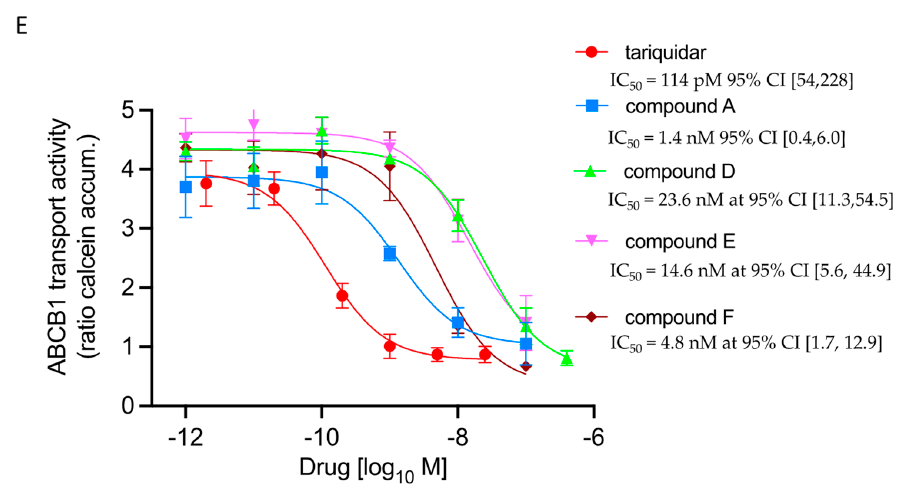
Figure 4. Potency of test compounds ‘A’, ‘D’, ‘E’, and ‘F’ for inhibition of ABCB1. ( A – D ) Histograms showing the increase in calcein accumulation in Flp-In-ABCB1 cells with increasing concentration of test compounds ‘A’, ‘D’, ‘E’, and ‘F’, respectively. ( E ) Non-linear regression analysis of ABCB1 activity (calculated using Equation (1)) versus test compound concentration. The regression curve for tariquidar is included for comparison. The mean activity +/ − standard error of the mean (SEM) is plotted ( n = 3 biological repeats). Calculated IC 50 and 95% confidence intervals are given.